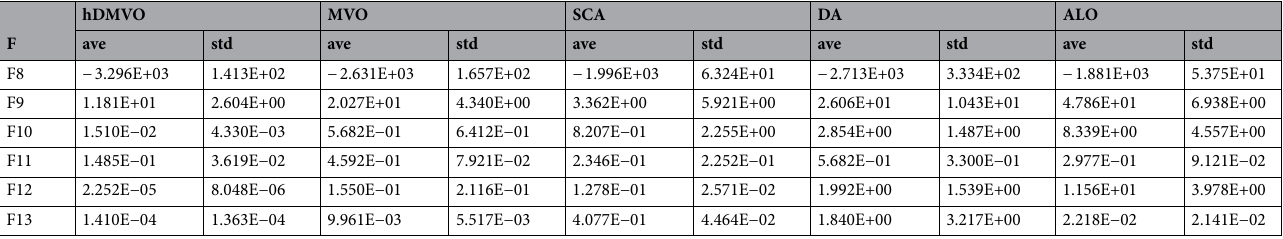
Table 6. Results of multi-modal benchmark functions.